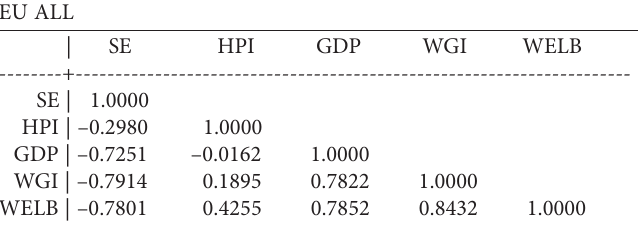
Table 11. Correlation Matrix (between SE, HPI, GDP, WGI and WELB) EU ALL